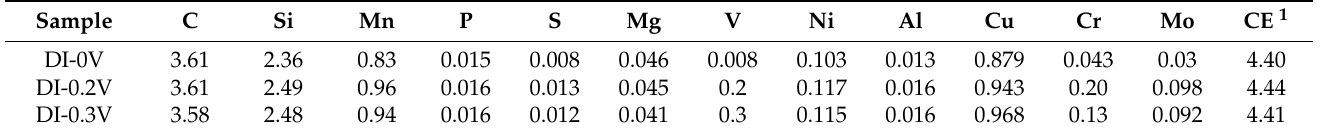
Table 1. Chemical composition of the unalloyed and alloyed camshafts with 0.2 and 0.3 wt % V. Sample C